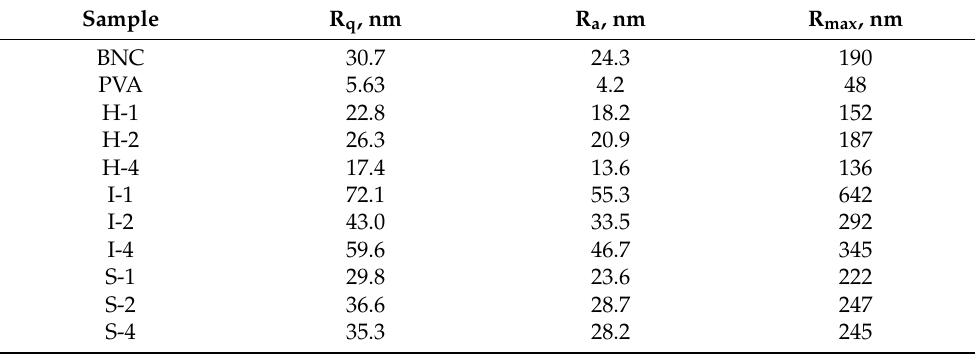
Table 4. Roughness parameters (calculated for 10 μ m × 10 μ m scan area): R q , R a , and R max of BNC, PVA, and their composites obtained by different methods.